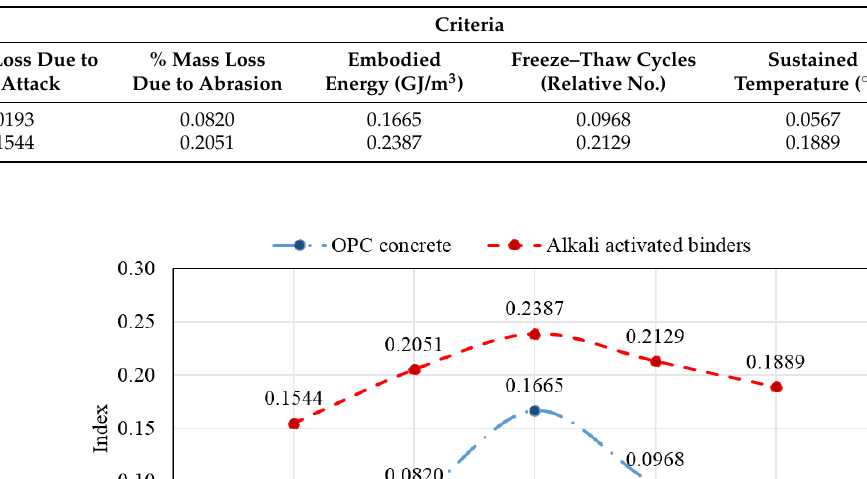
Table 7. Preference selection index for each alternative ( I i ).